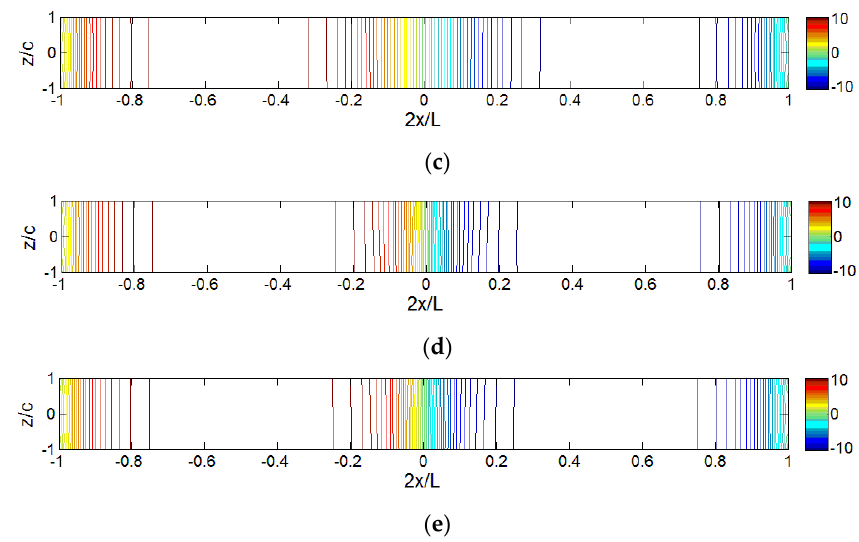
Figure 15. Iso-stress ( τ xz / q ) diagrams for sandwich panels under various locally distributed loads: ( a ) L p = L ; ( b ) L p = 0.5 L ; ( c ) L p = 0.2 L ; ( d ) L p = 0.01 L ; and ( e ) L p = 0.001.